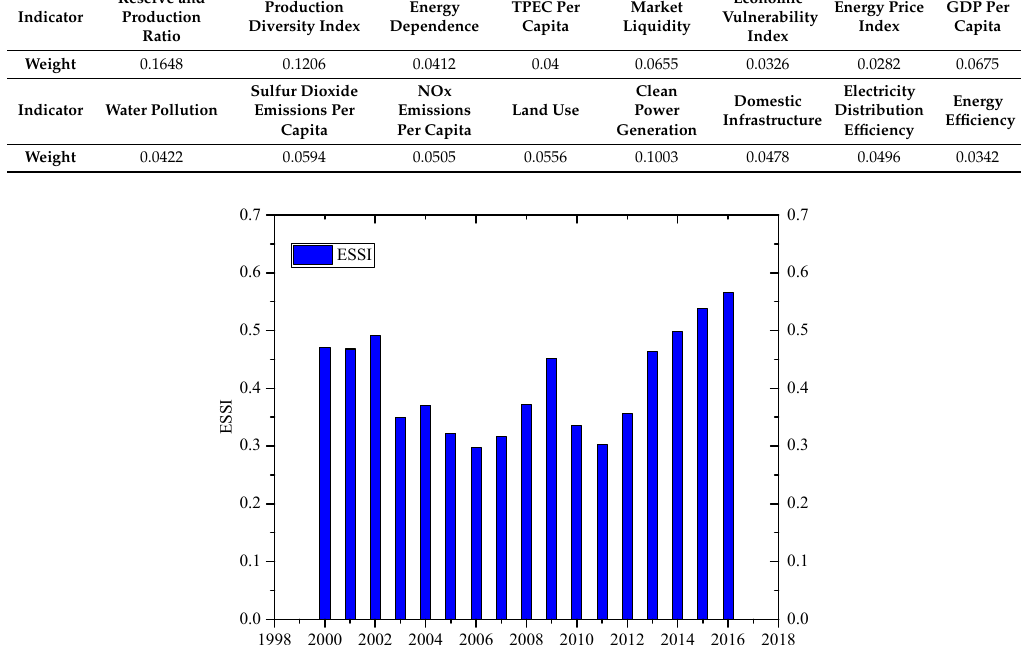
Figure 2. China’s energy supply sustainability level from 2000 to 2016.